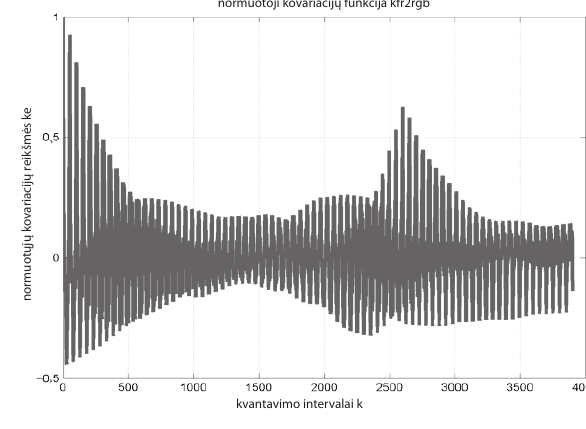
2 pav. Skaitmeninio vaizdo 1-osios iškarpos normuotoji Fig. 2. Normalised covariance function of the Digital image 1st fragment, applying RGB blue colour